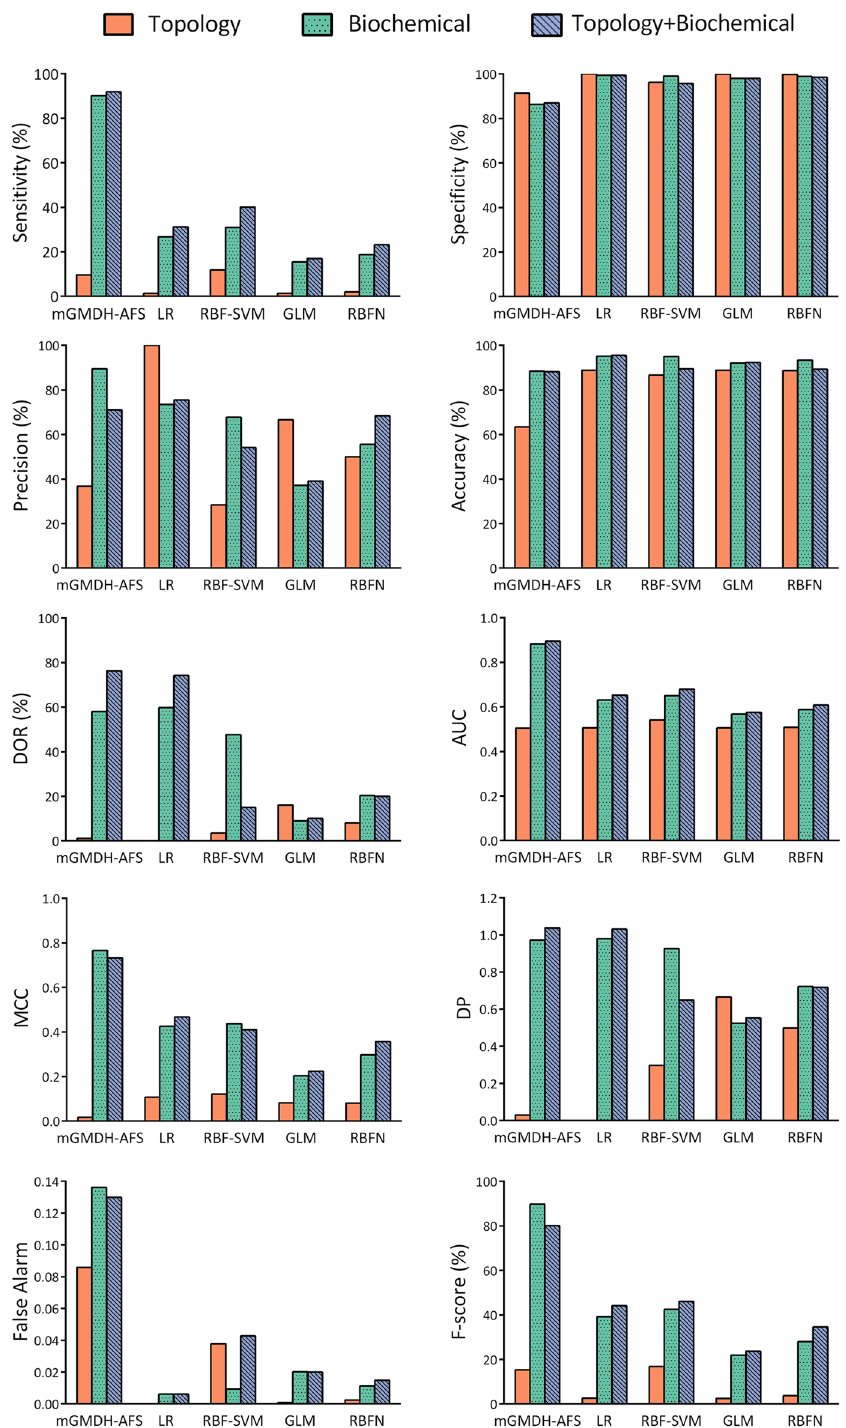
Figure 6. The novel machine could appropriately classify human proteins as drug targets or non-drug targets. The performance of the proposed mGMDH-AFS machine for drug target prediction based on biochemical or topology + biochemical features was acceptable and significantly superior to the examined standard machines including logistic regression (LG), radial basis function kernel support vector machine (RBF-SVM), generalized linear model (GLM), and radial basis function network (RBFN) as revealed by the hold-out validation. The proposed method significantly outperformed the state-of-the-art models (adjusted P ≤ 0.05). AUC: area under the receiver operating characteristic (ROC) curve; DOR: diagnosis odds ratio; MCC: Matthews correlation coefficient; DP: discriminant